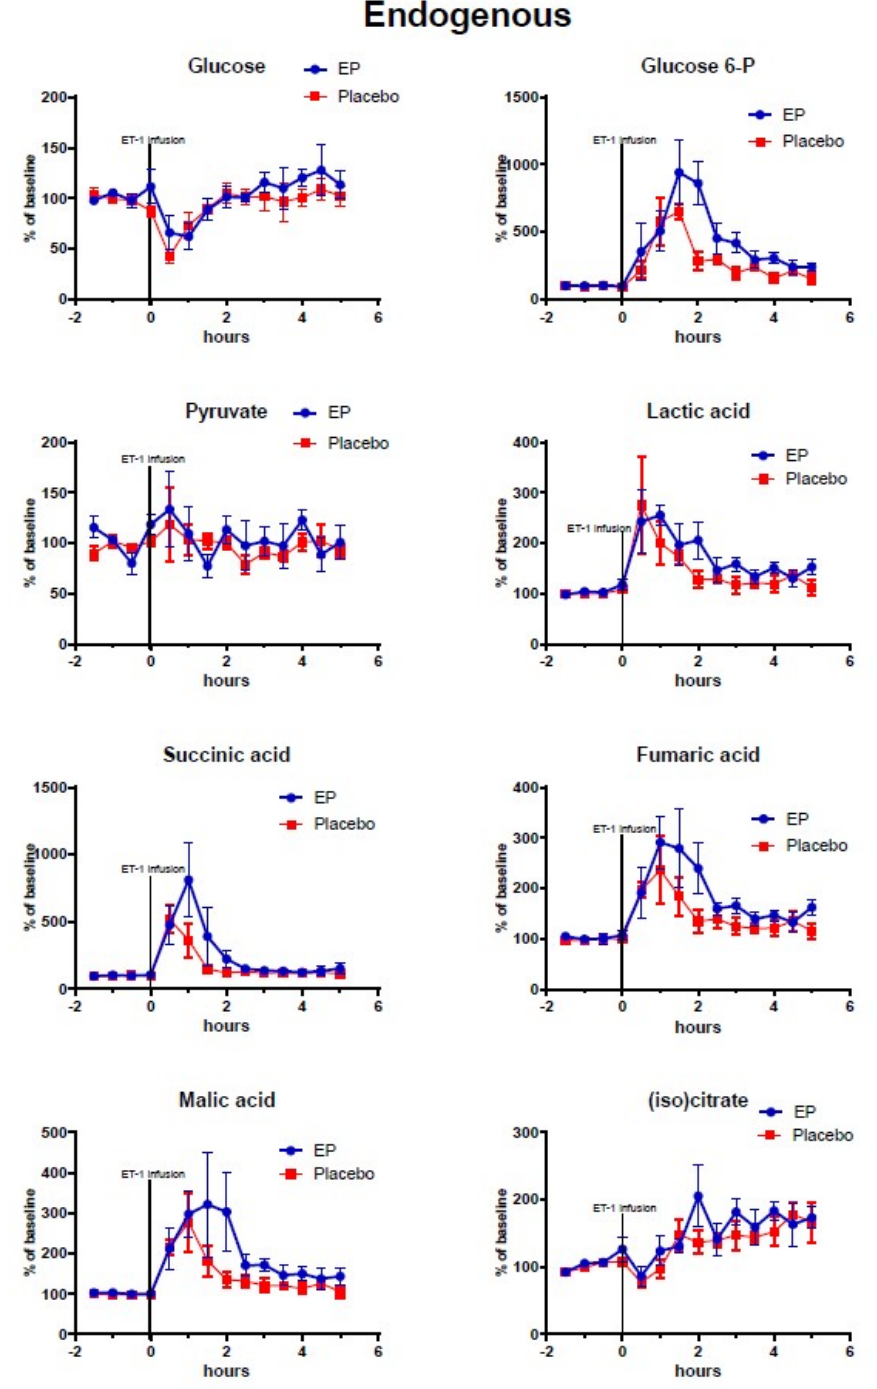
Figure 2. Changes of endogenous metabolites (non-labeled) in ipsilateral striatum after ethyl pyruvate (EP) and placebo treatment. Vasoconstriction of the medial cerebral artery (MCA) was induced by ET-1 infusion (150 pmol/15 µL/15 min) starting at time = 0 h. Blue symbols and line indicate data for rats treated with EP immediately after ET-1 infusion ( n = 5). Red symbols and line indicate data for control rats (placebo treatment after ET-1, n = 6). Metabolite data are expressed as mean ± SEM of percentage change of each rat’s own baseline.